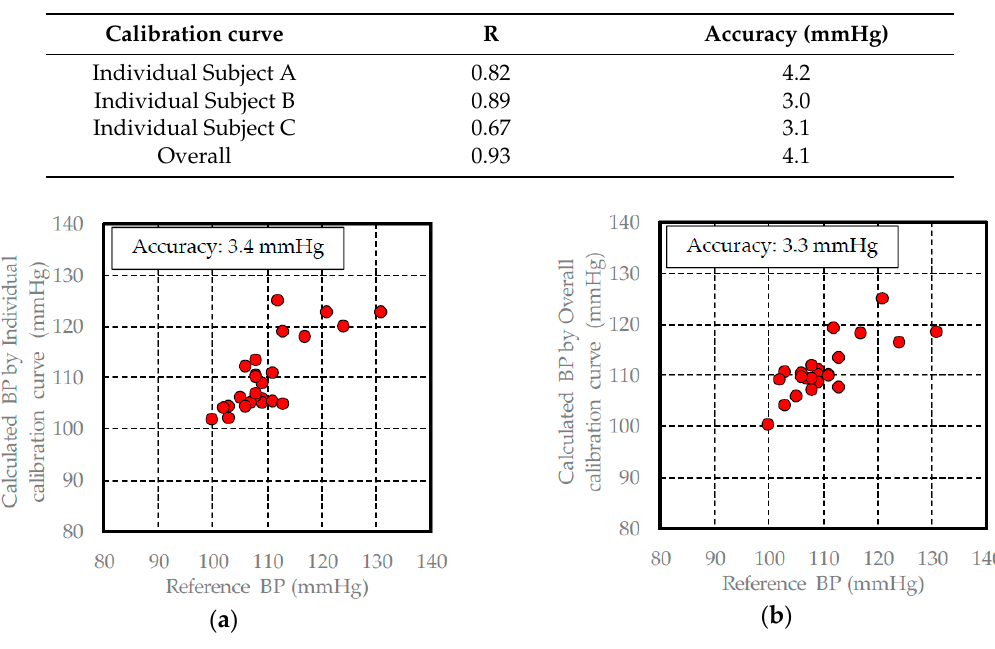
Figure 8. Validation results of the blood pressure in subject A: ( a ) calculated blood pressure results using the individual calibration curve; ( b ) calculated blood pressure results using the overall calibration curve.